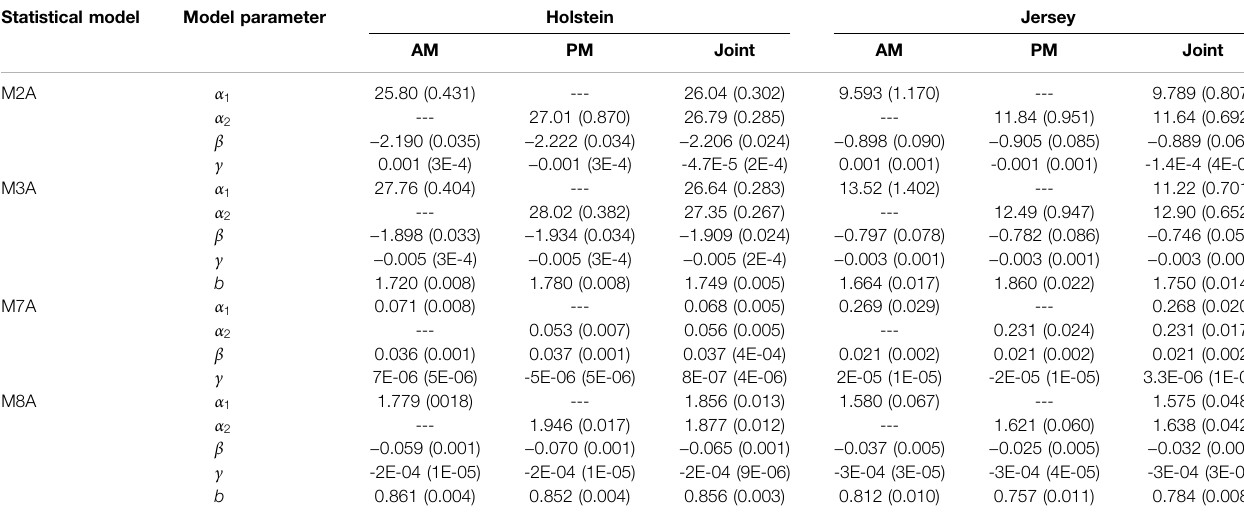
TABLE 4 | Estimated parameters obtained from four models (M2A, M3A, M7A, and M8A), each implemented separately or jointly for known morning (AM) or evening (PM) milk yields a,b . Statistical